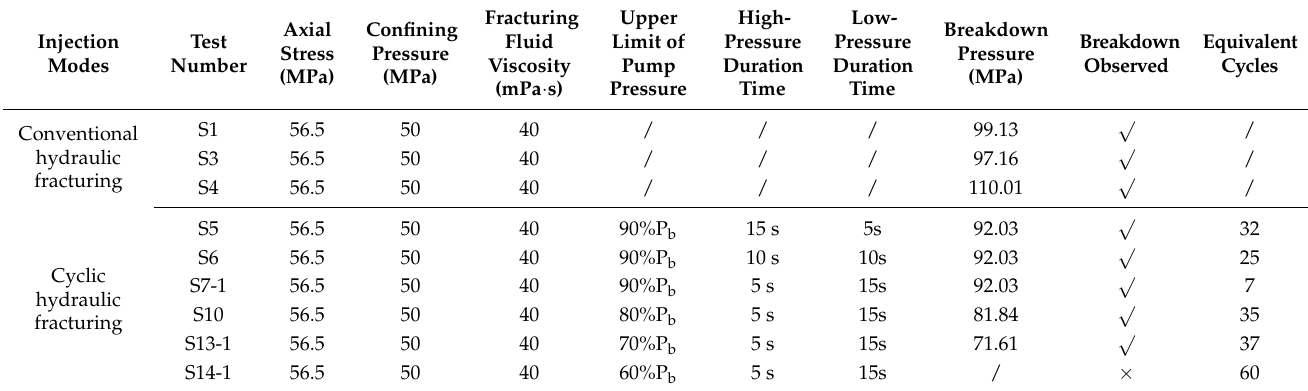
Table 2. Summary of experimental parameters and results.